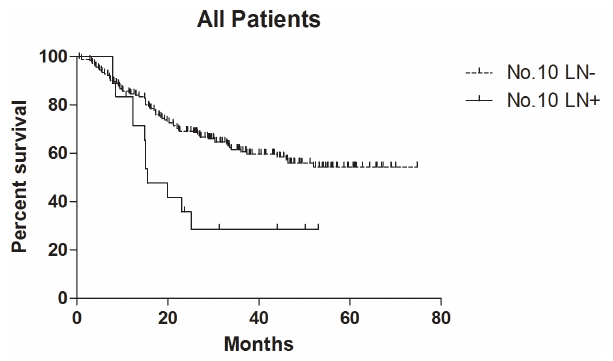
Figure 2. Kaplan-Meier survival analysis of No.10 LNs for all patients.